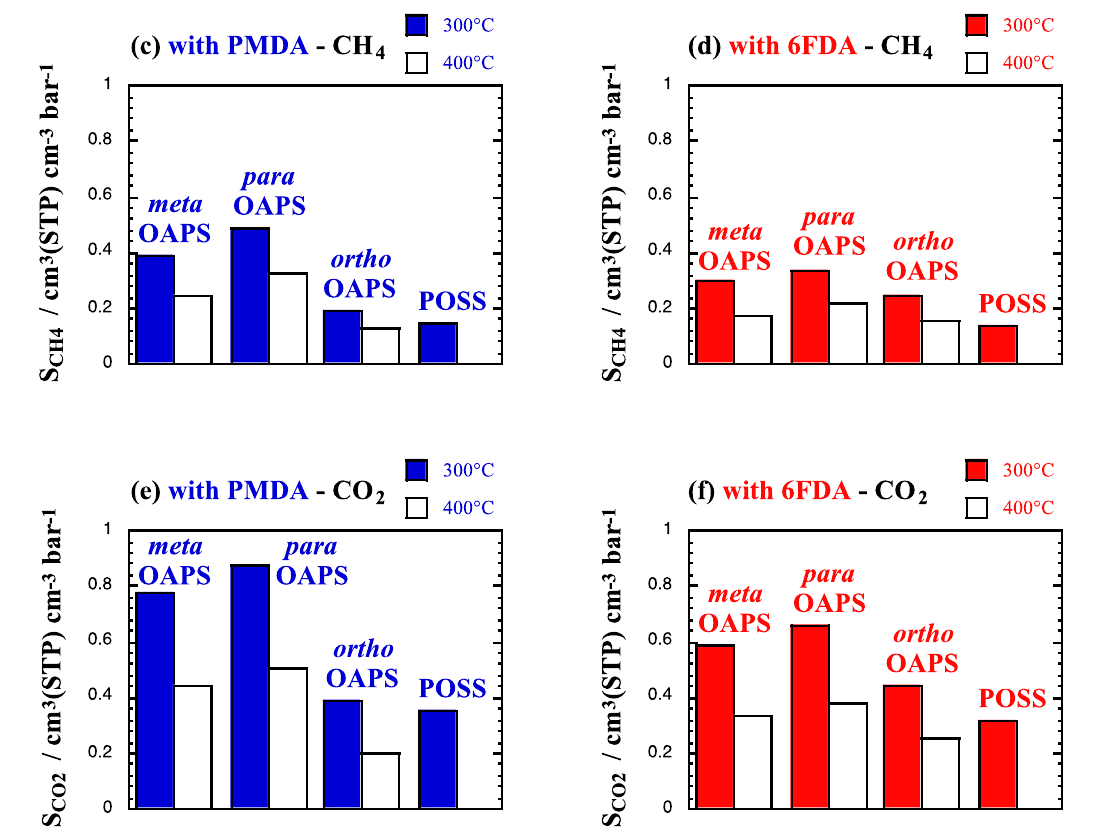
Figure 5. Single-gas solubility coefficients S gas at 300 ◦ C and 400 ◦ C in the PMDA and 6FDA polyOAPS/POSS-imides for ( a , b ) N 2 , ( c , d ) CH 4 and ( e , f ) CO 2 feeds at 60 bar. The maximum standard error is 0.002 cm 3 (STP) cm − 3 bar − 1 . Table 4. Average percent of volume swelling upon sorption of N 2 , CH 4 and CO 2 penetrants in the polyOAPS/POSS-imides networks at both 300 ◦ C and 400 ◦ C and at 60 bar. The maximum standard error is